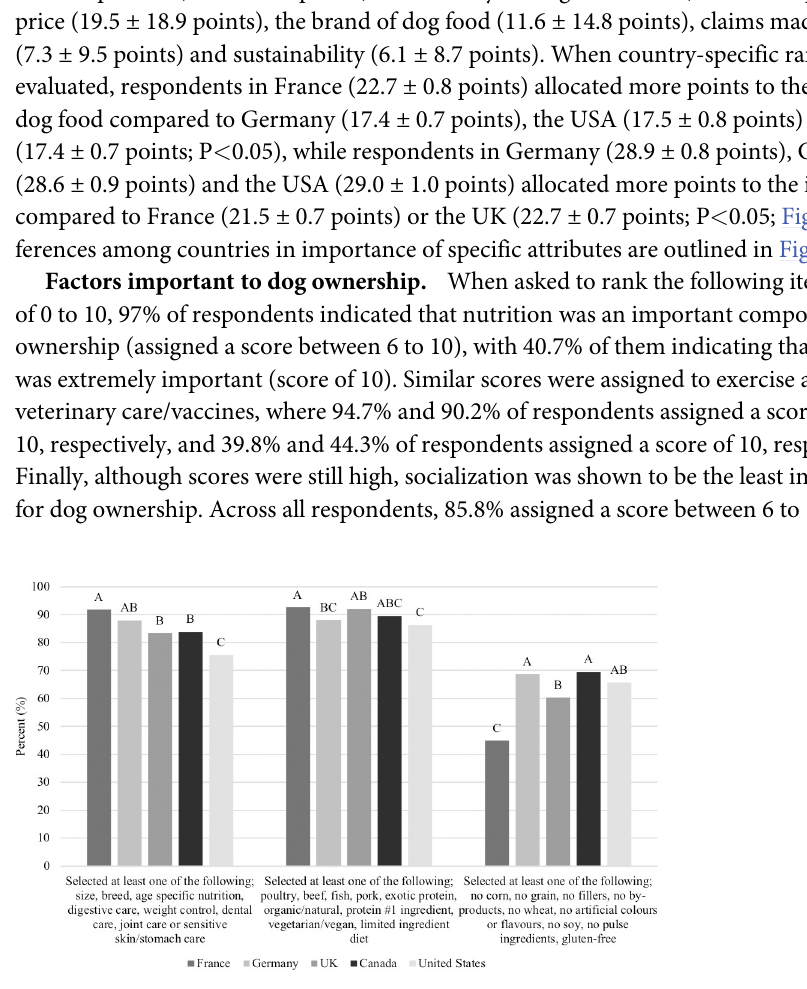
Fig 6. Percent of respondents that look for at least one of the above options when selecting a pet food (n = 3,298). Proportions in the same category that do not share a common letter are significantly different at P <